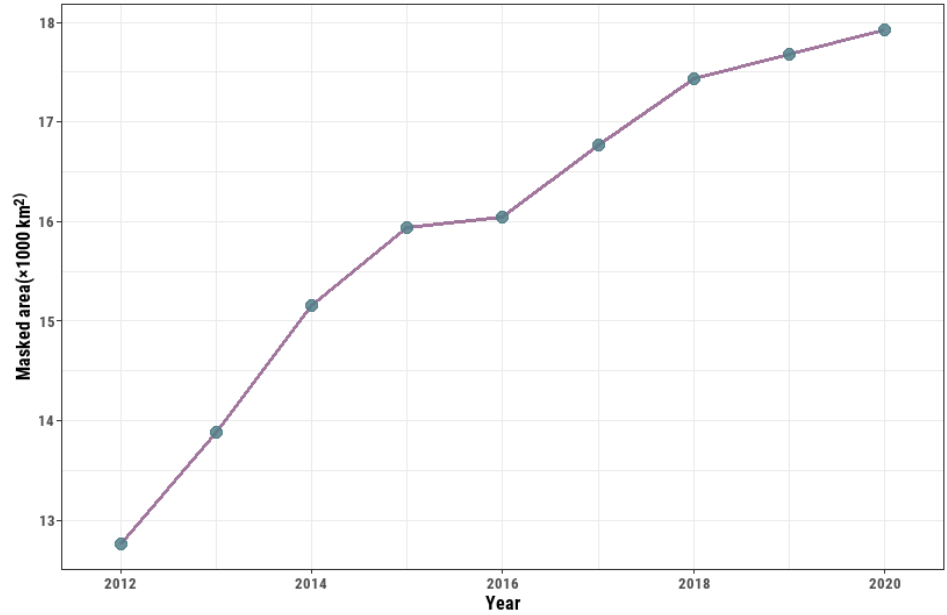
Figure A1. The annual variation in the total masked area (i.e., settlement and bare area) between 2012 and 2020.